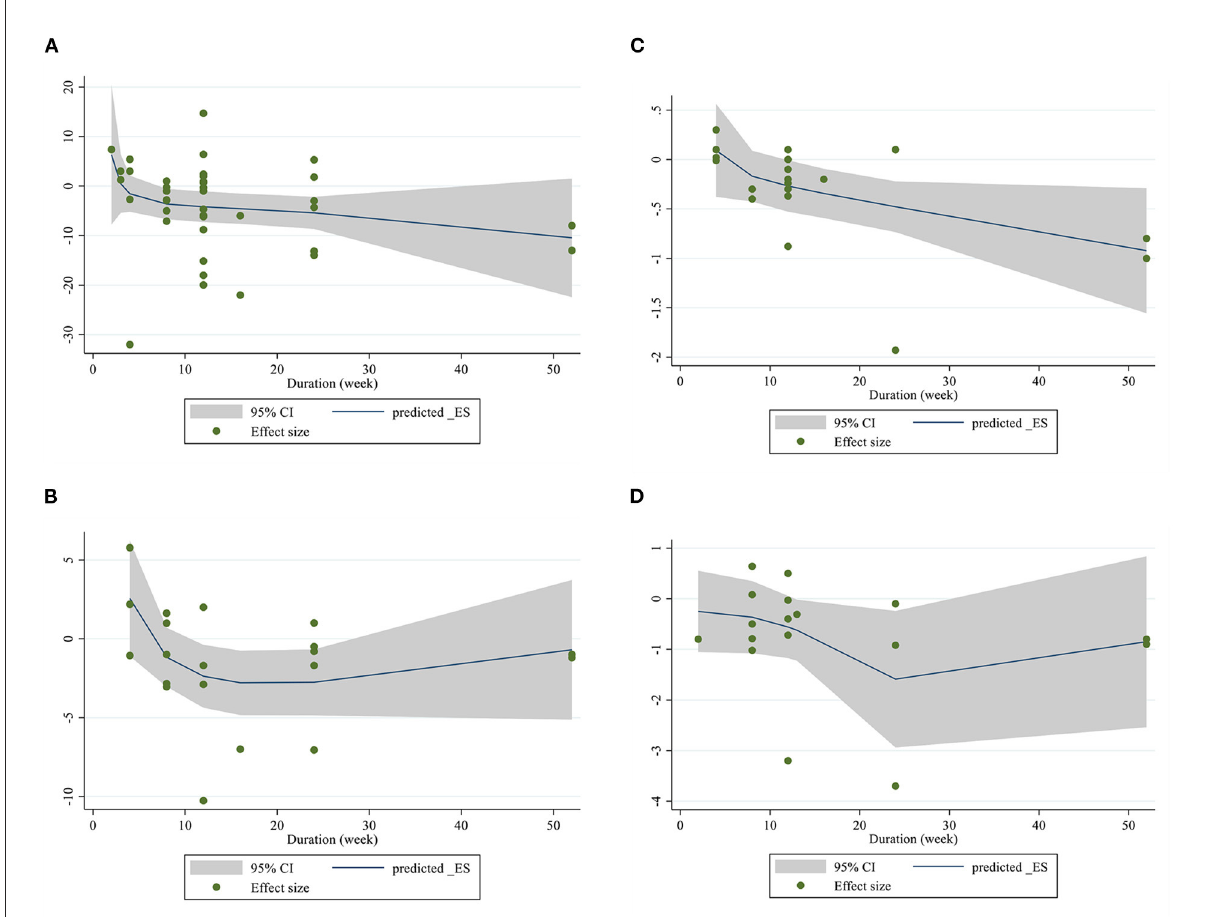
FIGURE5 Non-linear dose-response relations between L-carnitine consumption and absolute mean differences. Dose-response relations between duration of intervention (week) and absolute mean differences in (A) FBG (mg/dl); (B) Insulin (pmol/l); (C) HbA1c (%); (D) HOMA-IR. FBG, fasting blood glucose; HOMA-IR, homeostasis model assessment for insulin resistance; HbA1C, hemoglobin